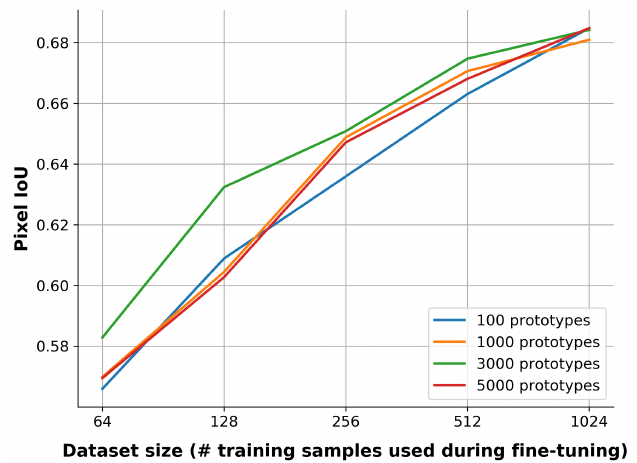
Figure 5. Pixel IoU plotted against dataset size for the INRIA building segmentation task. Additional pre-training using 3000 prototypes, matching the original model, outperforms all the other models (green line), although the gap is hardly noticeable as the data size